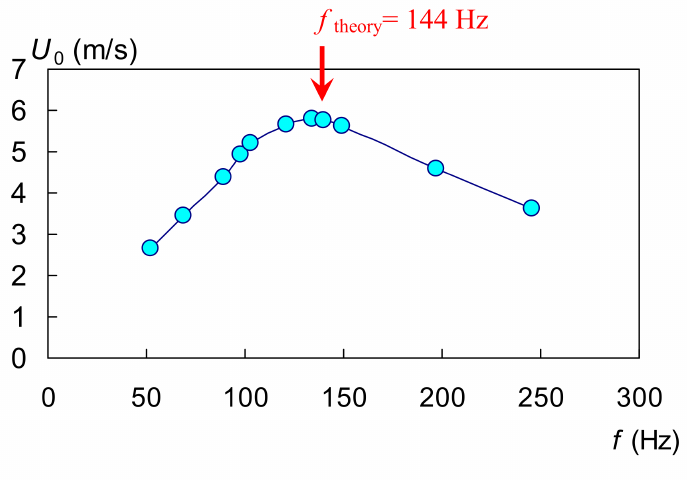
Figure 3. Frequency characteristics of the SJ actuator evaluated for P = 2.0